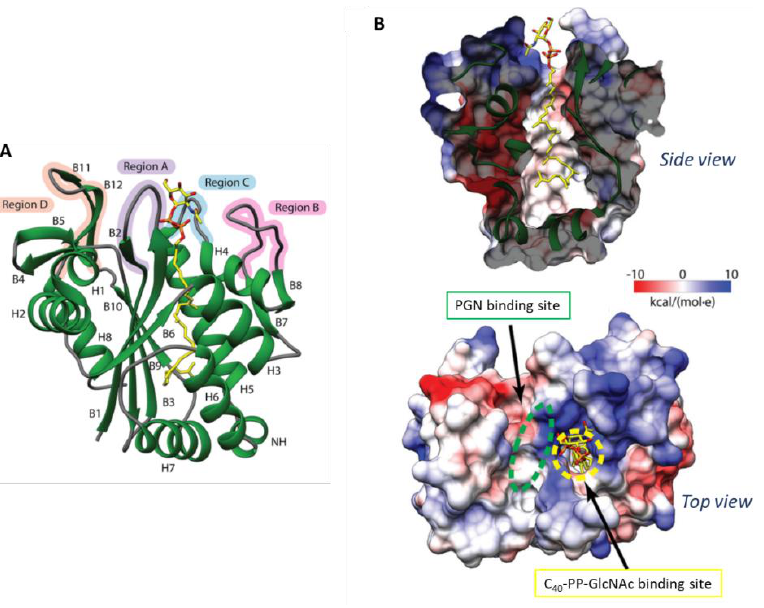
Figure 3. Crystal structure of S. aureus LcpA. ( A ) ribbon structure of LcpA (green) bound to C 40 - PP –GlcNAc (yellow) with labelled structural features. H, helix; B, β-strand; NH, non-conserved helix. The active site is surrounded by four regions, designated here as A, B, C, and D. ( B ) The lipid-binding pocket of LcpA is shown in a cross-section of a side view with an electrostatic potential surface. The locations of the substrate-binding sites are outlined in the top view, figure modified after [106].